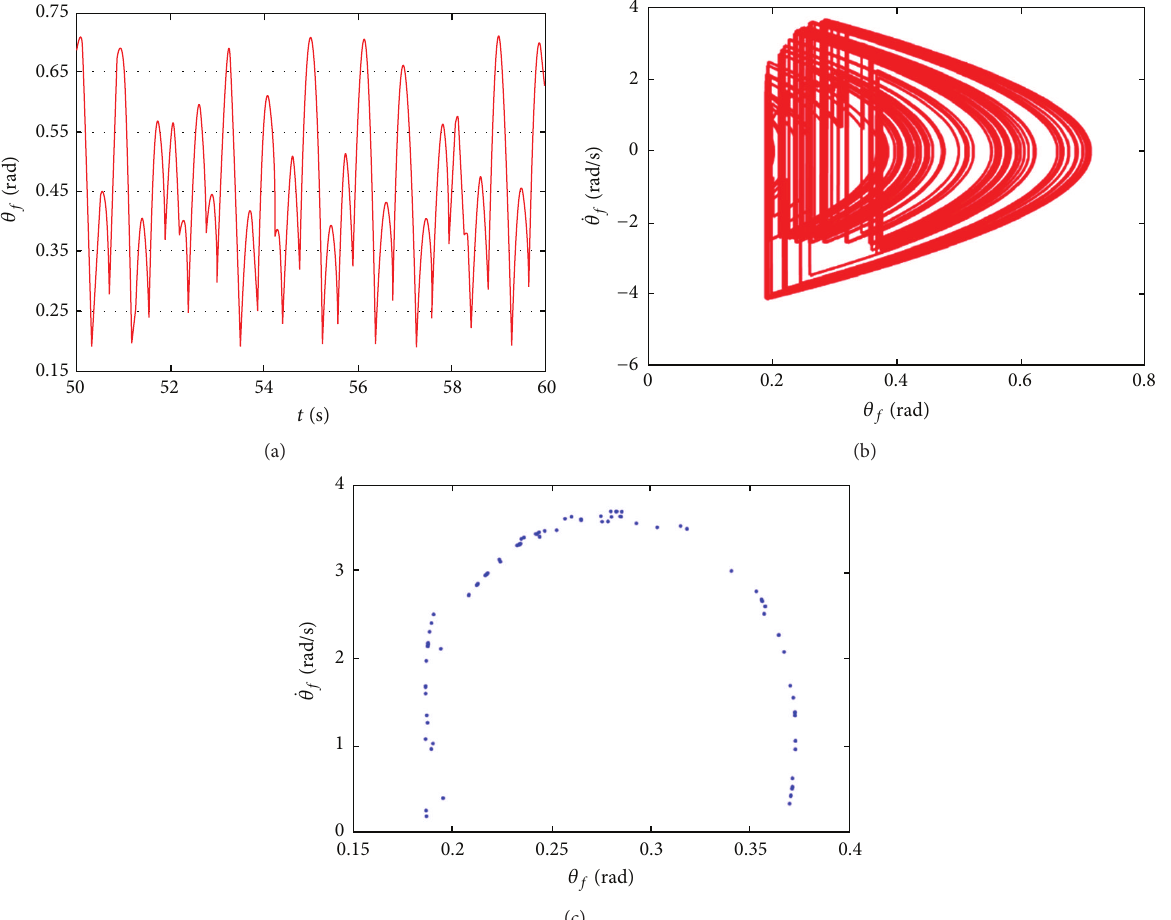
Figure 10: Chaos motion when 𝜔 = 21.7 rad/s: (a) time history; (b) phase diagram; and (c) Poincar´e map.